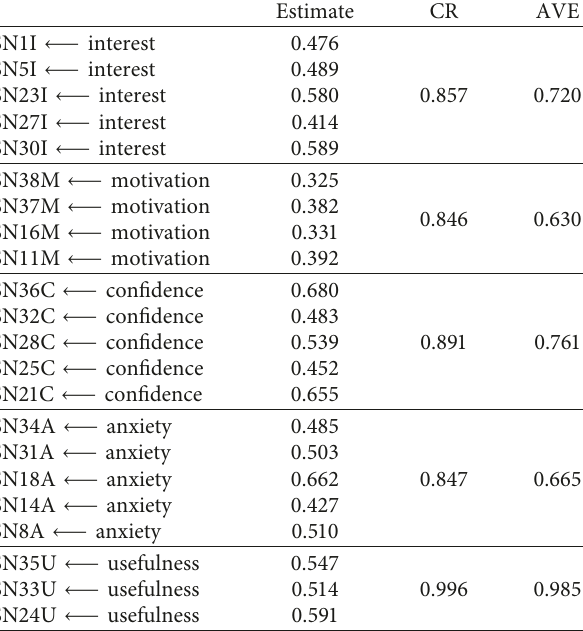
Table 7: Regression weights for the modified path model. Relationships